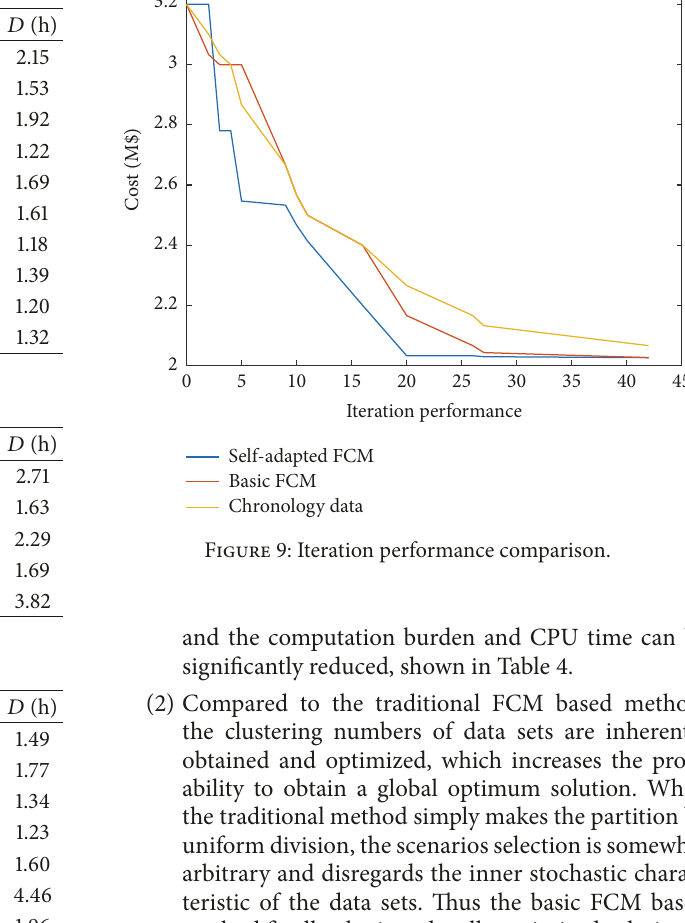
Table 1: Markov model of WT/35 kW.